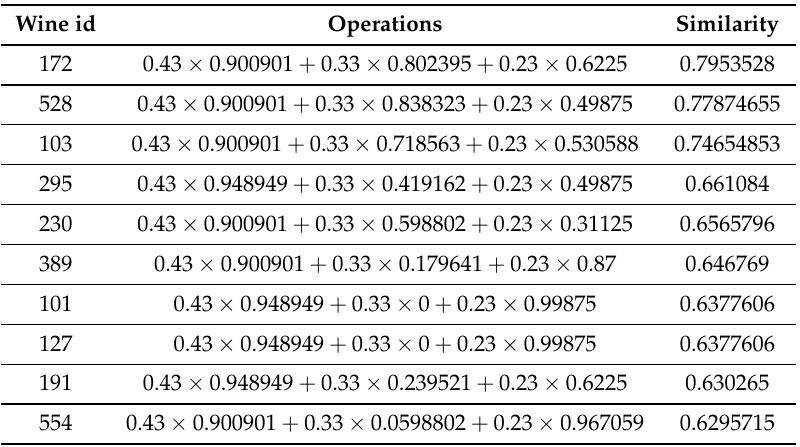
Table 4. Obtaining the similarity value for each item in the